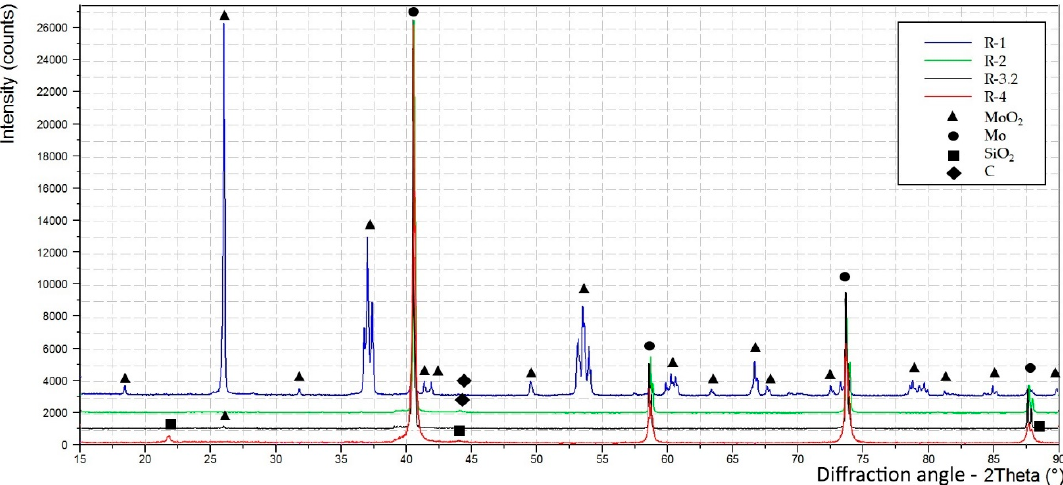
Figure 7. X-ray diffraction (XRD) spectra of the products of different reduction experiments.